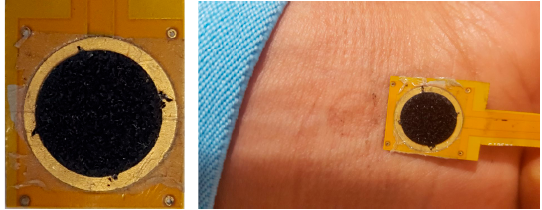
Figure 10. Photographs showing the PPy-coated pvCNT after the ECG signal capture experiments.